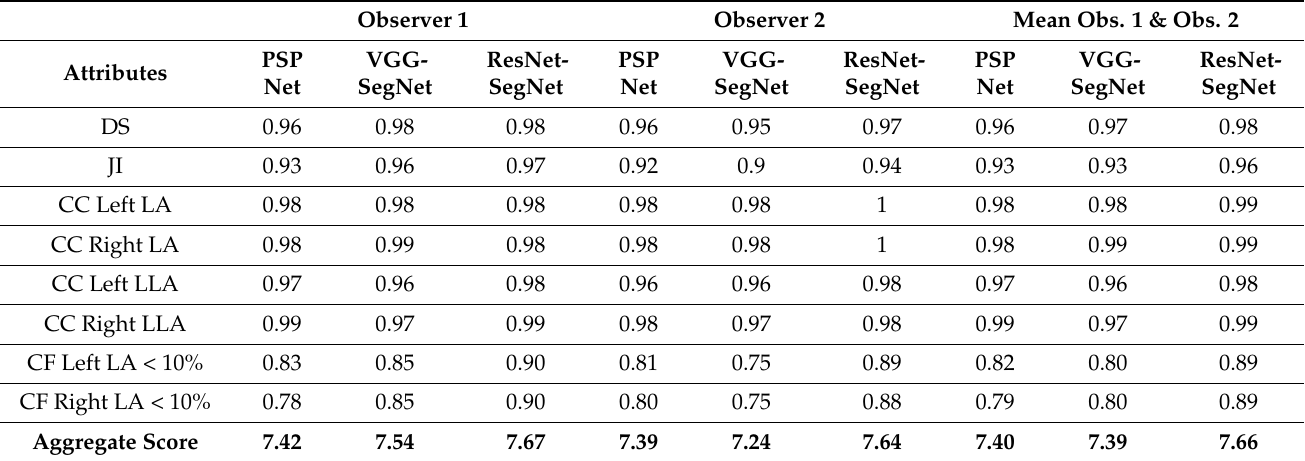
Table 6. Comparison of PE metrics for Observer 1 and Observer 2 and their